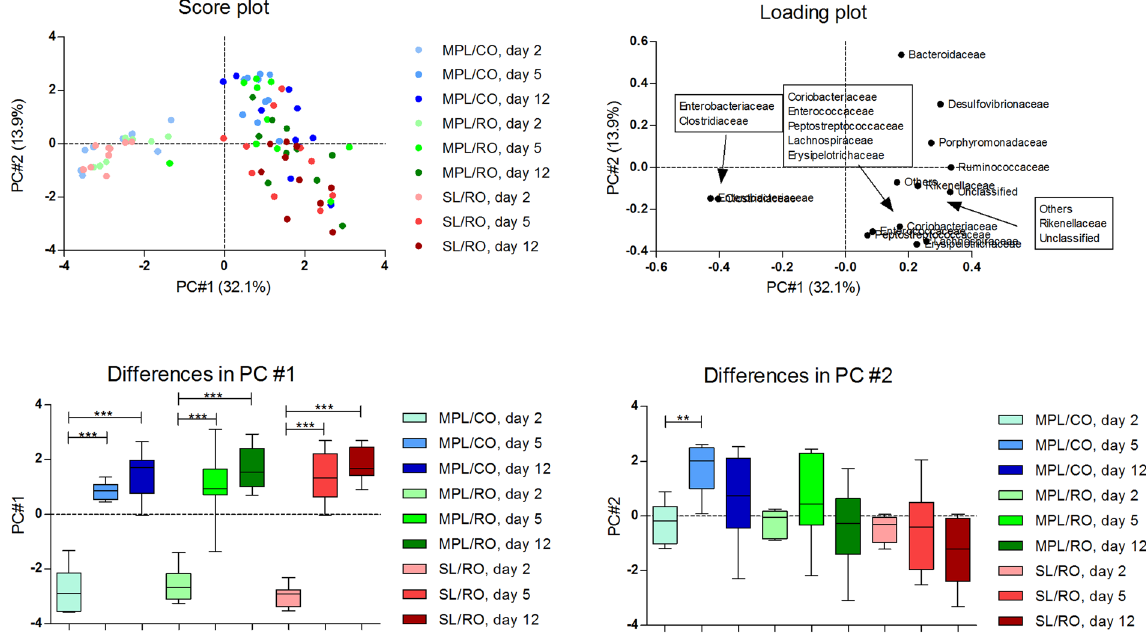
Figure 1. Fecal bacterial composition in mice at bacterial family level at Day 2, 5 and 12 after emulsion consumption, as assessed by Principal Component Analysis. ( A ) Score plot, ( B ) Loading plot, ( C and D ) Differences between days by PC #1 ( C ) and PC #2 ( D ) calculated by a repeated measures one-way ANOVA using a Tukey’s test as post-test. Differences between groups were calculated using an unpaired t-test with Welch correction. Colors refer to the three different lipid emulsions: MPL/CO (blue), MPL/RO (green) and SL/RO (red). Color intensity increases with number of days. On the loading plot ( B ), samples are distributed by the PC #1 (32.104%) and PC #2 (13.932%). Asterisks indicate significant differences ( * p < 0.05, ** p < 0.01, *** p < 0.001). PC: Principal Component, ANOVA: Analysis of variance, MPL, Milk phospholipids,